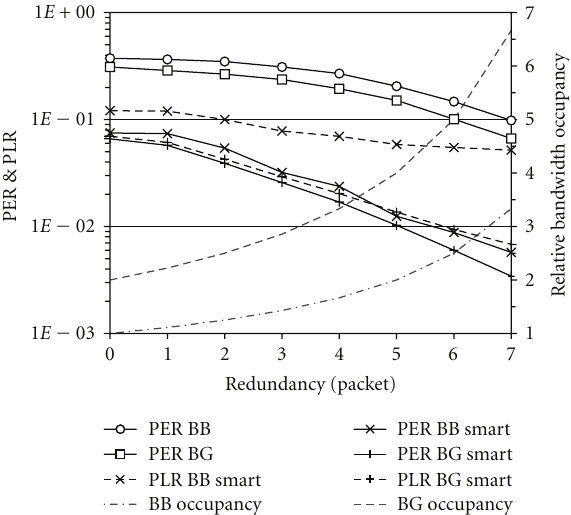
Figure 9: PER, PLR, and bandwidth occupancy versus redundancy with RSE (10, k ) in highway and rural environments.